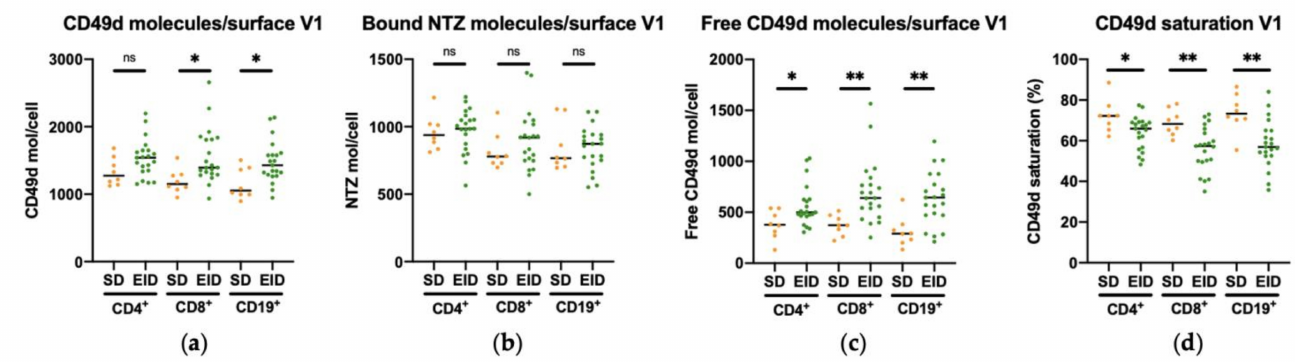
Figure 3. CD49d surface molecules levels and saturation percentage in CD4 + and CD8 + T lymphocytes, and CD19 + B lymphocytes in RRMS patients under Natalizumab treatment in SD or EID. Mean of ( a ) CD49d molecules/cell surface, ( b ) bound NTZ/cell surface, ( c ) free CD49d molecules/cell surface, and ( d ) CD49d saturation percentage in CD4 + and CD8 + T lymphocytes, and CD19 + B lymphocytes in the SD ( n = 8) and EID ( n = 21) groups. Each dot represents the number of PE molecules per cell for each patient in the first extraction (V1), translated into the levels of the corresponding antibodies (anti-CD49d PE and huIgG4 Fc PE). EID, extended interval dosing; NTZ, natalizumab; SD, standard dosing. Ns: p > 0.05, * p < 0.05, ** p <